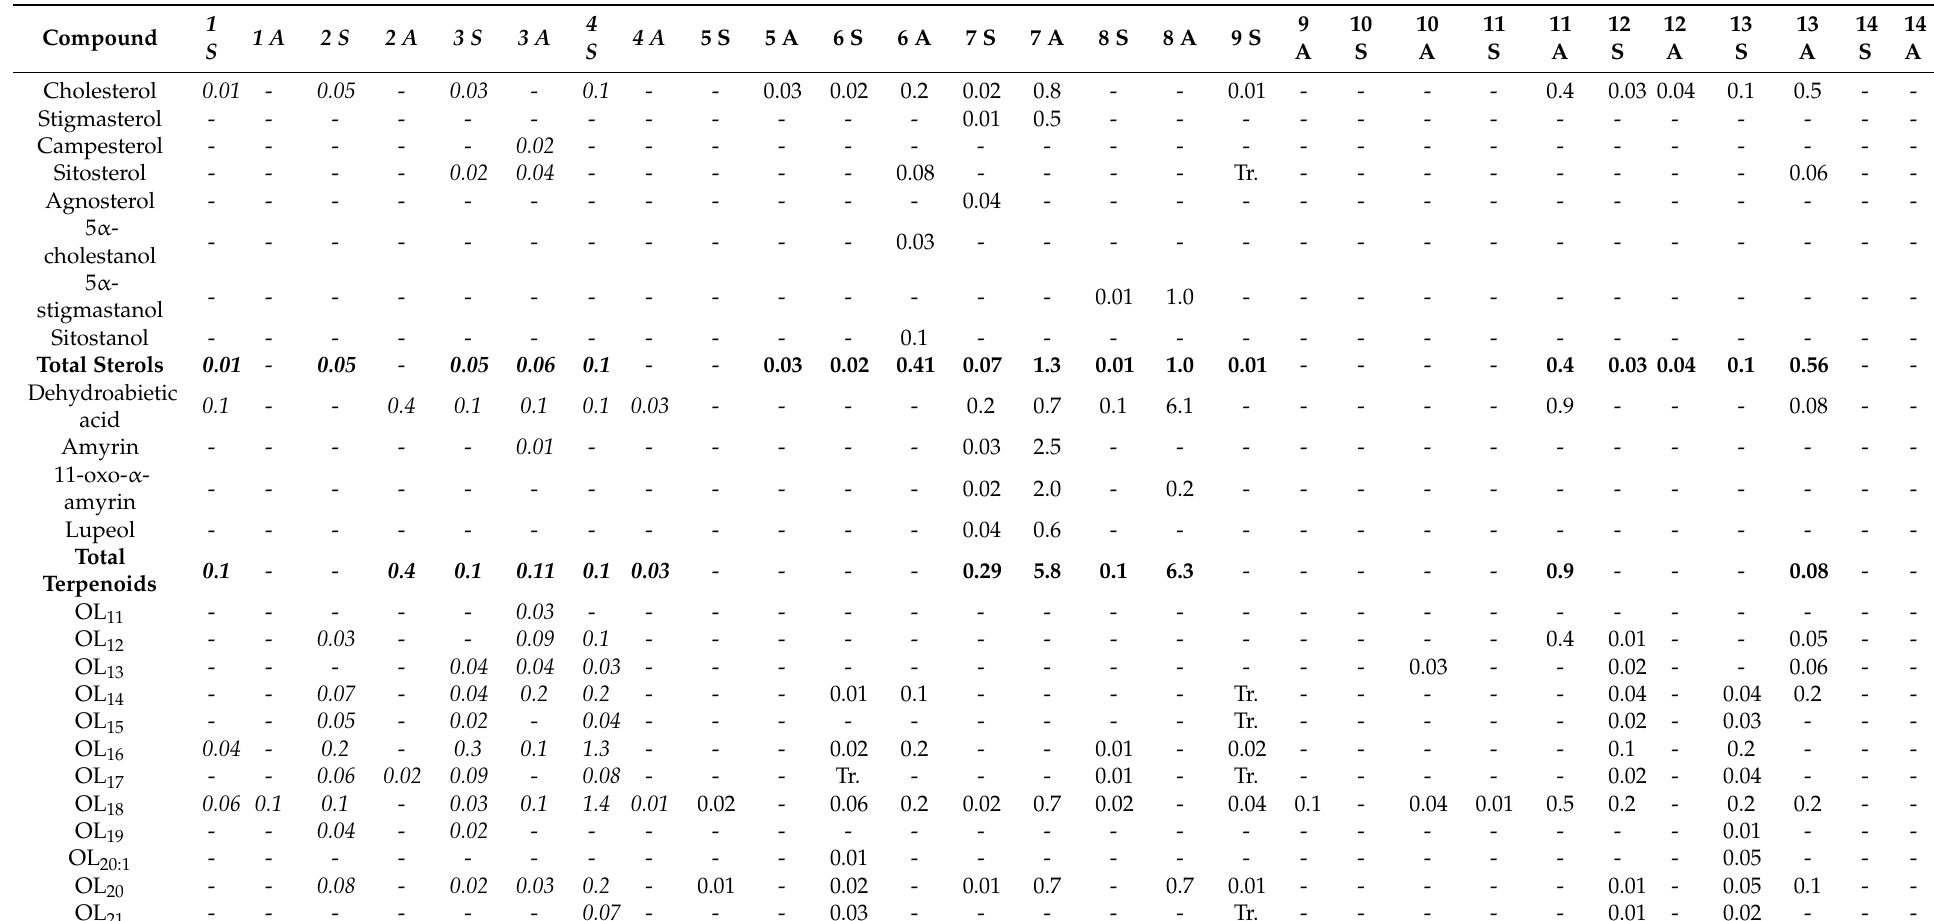
Table 2. Comparison of µ g neutral compounds per g of sherd extracted from sherds using acidic methanol and chloroform/methanol extraction methods. Neutral compounds from chloro- form/methanol extractions are quantified from the saponified neutral fraction of the chloro Figure 1. The samples marked with ‘S’ are chloroform/methanol extracted, those marked with ‘A’ are extracted with acidic methanol. Samples containing less than 0.01 µ g/g were marked Tr, for trace. Absence of a compound is indicated by “-” Pairs sampled at a different time are in italics. Alkanols are described in the form OL carbon # , while alkanes are described in the form AL carbon # . Different lipid classes are totaled in lipid in µ g lipid/g sherd sampled for easier comparison of extraction methods. Results for samples 1–4 are given in italics, as they were not sampled